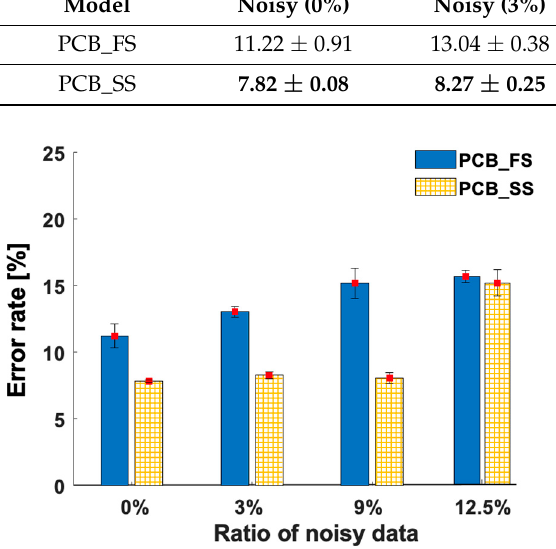
Table 7. Error rates (%) of test data with different ratios of noisy data (Best result in bold). Model Noisy (0%) Noisy (3%) Noisy (9%)